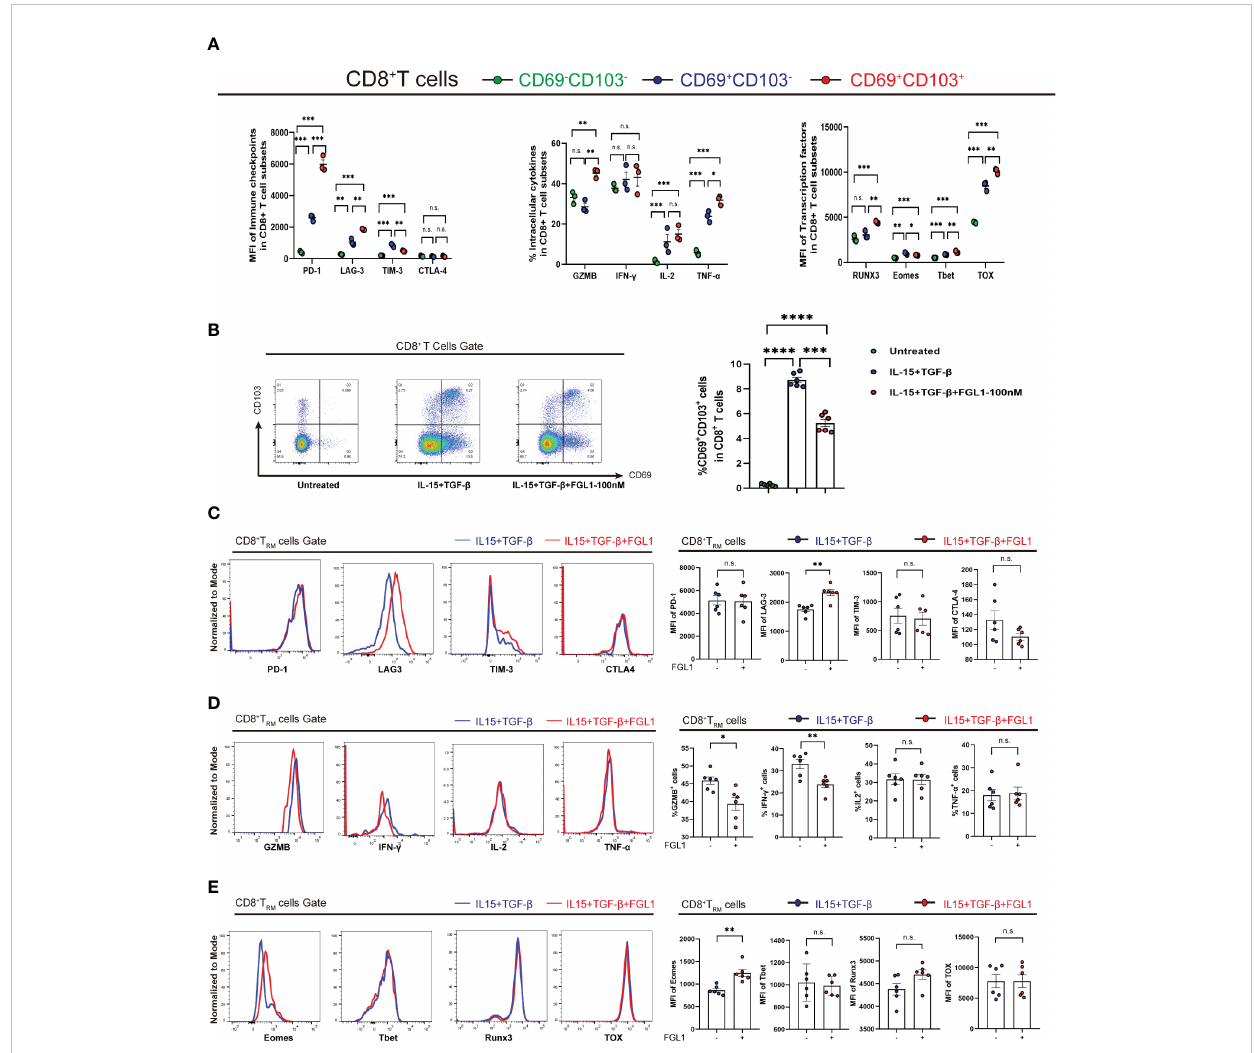
FIGURE 4 FGL1 expression inhibits the proliferation of CD8 + T RM cells in vitro (A) PBMCs were cultured in the presence of IL-15 (50 ng/mL) for 3 days and then with TGF- b (50 ng/mL) for an additional 3 days to activate CD8 + T RM cells. The expression of the markers of CD8 + T RM cells and other CD8 + T-cell subpopulations was determined. (B) FGL1 (100 nM) was added to the cultures, and the percentage of CD8 + T RM cells was detected after activation. (C) Expression of CD8 + T RM cell surface molecules, such as PD-1, LAG3, TIM-3, and CTLA-4, was detected after activation. (D) Expression of CD8 + T RM cell cytokines, such as IFN- g , IL-2, and TNF- a , as well as GZMB, was detected after activation. (E) Expression of CD8 + T RM cell transcription factors, such as Runx3, Eomes, T-bet, and TOX, was detected after activation. (A – E) A paired t -test. Bars represent mean ± SEM. FGL1, fi brinogen- like protein 1; GZMB, granzyme B; PBMC, peripheral blood mononuclear cell. (* P < 0.05, ** P < 0.01, *** P < 0.001, **** P < 0.0001). n.s. means not sigini fi